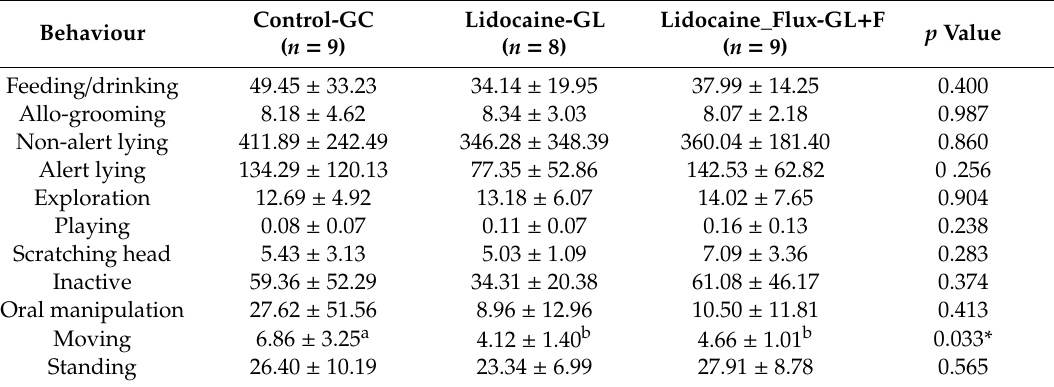
Table 4. Average duration ( ± SD), expressed in seconds, of each bout of manifestation of state behaviour in the three treatments during the observation period, and relative levels of significance of the di ff erences. Significance: * p < 0.05; letters (a and b) on the same line indicate statistically significant di ff